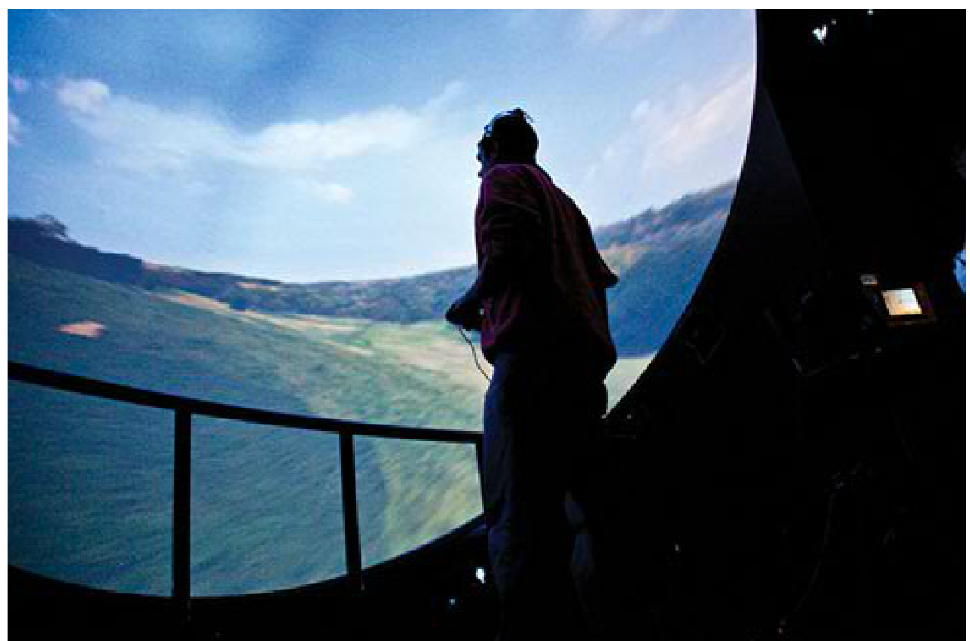
Figure 2. Still from Psychasthenia 1 . Courtesy of the authors. boding scenes, including claustrophobic tunnels, amor- phous figures lurking in cells, and a twisting corridor peo- pled by grimacing patients subjected to galvanic facial contortions. After making it through the game world, which adapted to the head movements of the user by af- fecting lighting, tunnel size, and so forth, the user was in- evitably “diagnosed” as suffering from “psychasthenia”. The in-joke was that there was no way out; the end- diagnosis was an inevitable condition of